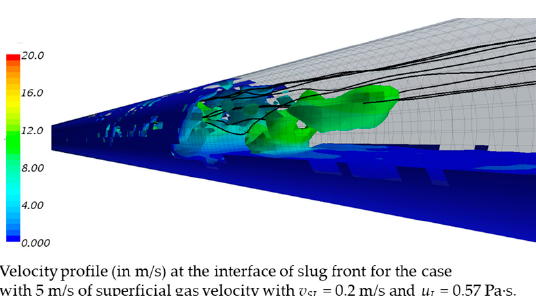
(15) Figure 5. Composite correlation for slug flow [17]. In the case of the flow coefficient, C o , which needs to be optimized to calculate v LLS in Equation (14), several different correlations of translational velocity are compared to the previously obtained experimental data. Tables 1 and 2 summarize the experimental dataset and the compared correlations, respectively, to optimize the proper value of C o . The model of Choi et al. [36] requires the proper correlation of gas void fraction. Woldesemayat and Ghajar [37] improved the correlation